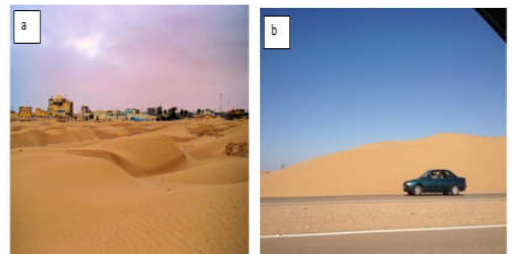
Figure 2. Sandy dunes threatening Laâyoune region dunes threatening Laâyoune region infrascture. a Dunes and urban area. b Sandy dunes crossing the road.